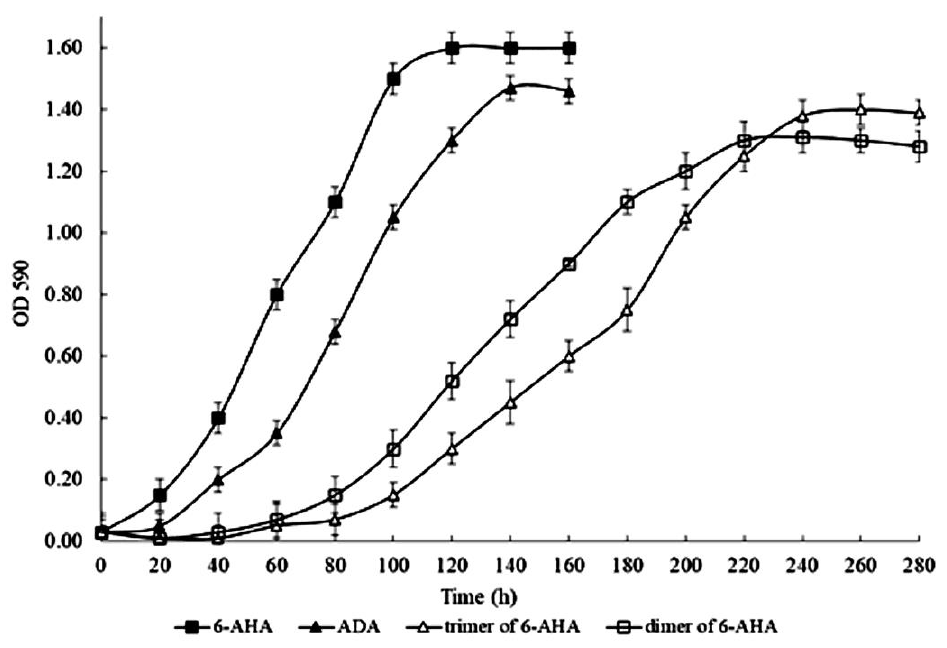
Figure 5. Growth dynamics of Brevibacterium epidermidis BS3 in a mineral medium supplemented with linear nylon oligomers and caprolactam intermediates as sole sources of carbon and energy (concentration of substrates, 1.0 g/L).